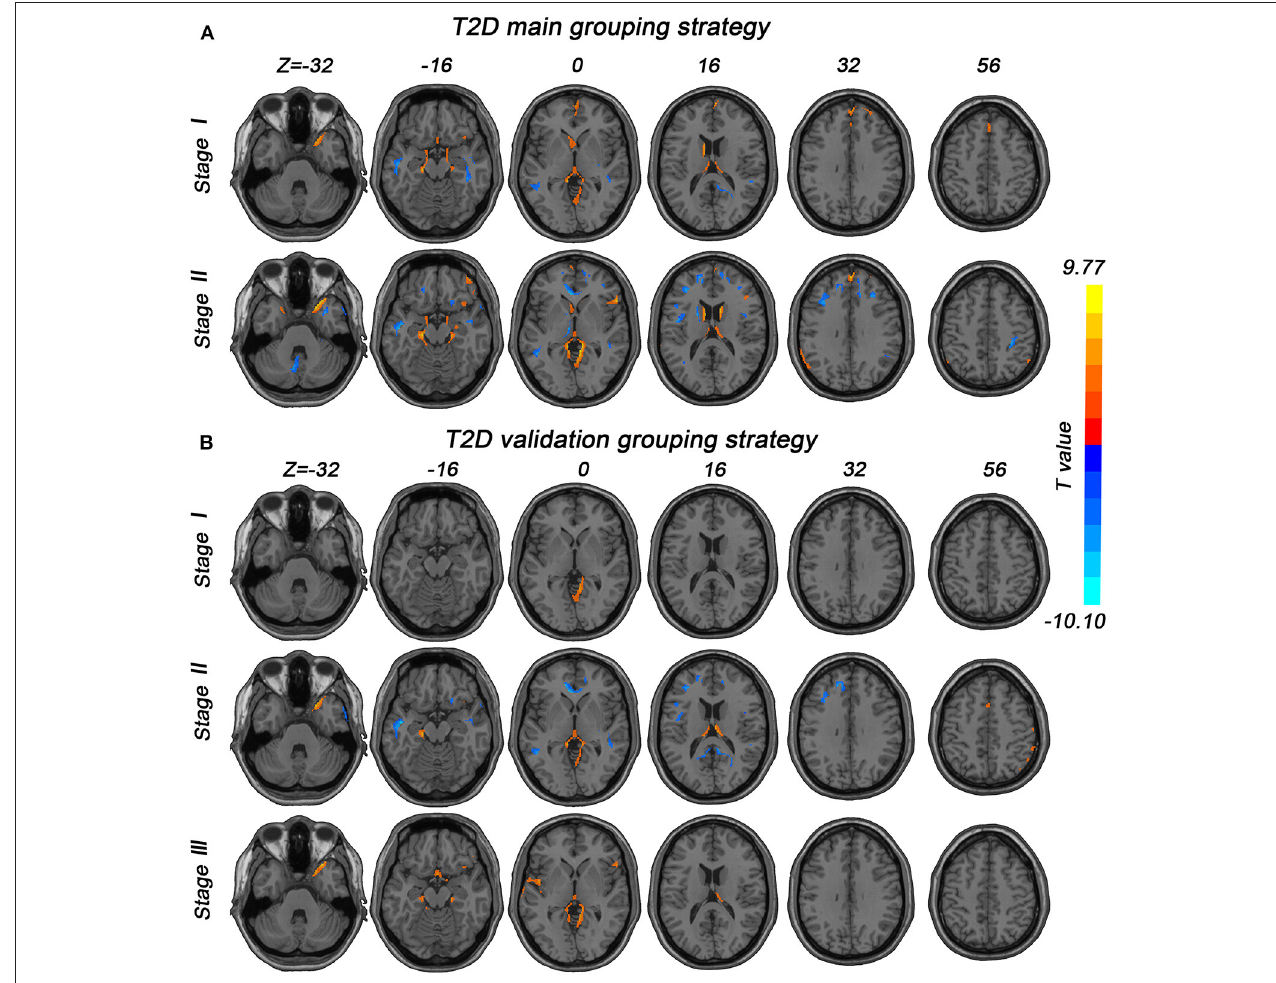
FIGURE 1 | Stage-specific GMV alterations in T2D patients under different grouping strategies. GRF correction (voxel-level p < 0.001, cluster-level p < 0.01) was used in all subgroups. (A) Stages in the main grouping strategy were categorized by illness duration (stage 1, duration < 9 years; stage 2, duration ≥ 9 years). (B) Stages in the validation grouping strategy were also divided by illness duration (stage 1, duration < 6 years; stage 2, 6 ≤ duration ≤ 11 years; stage 3, duration > 11